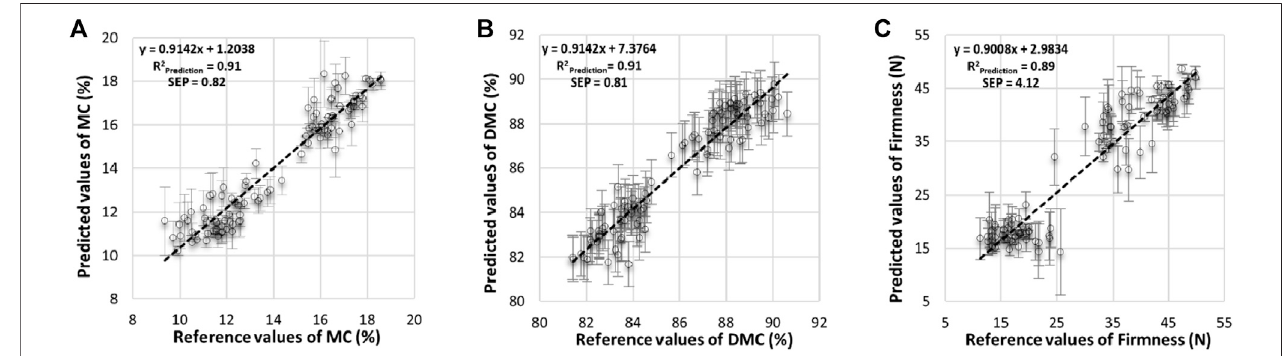
FIGURE6| ScatterdiagramsofreferencevspredictedvaluesforMC,DMC,and fi rmness(F)accompaniedbystandarddeviationaserrorbarsofpredictedvalues.